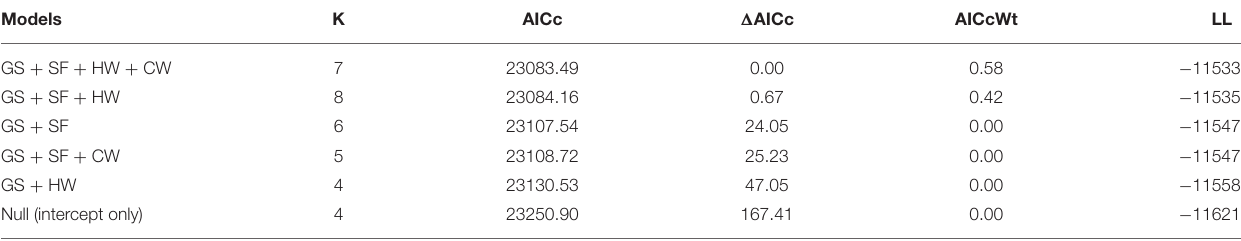
TABLE 2 | Model selection table showing the five best models of annual tree growth in the northern study region. Models